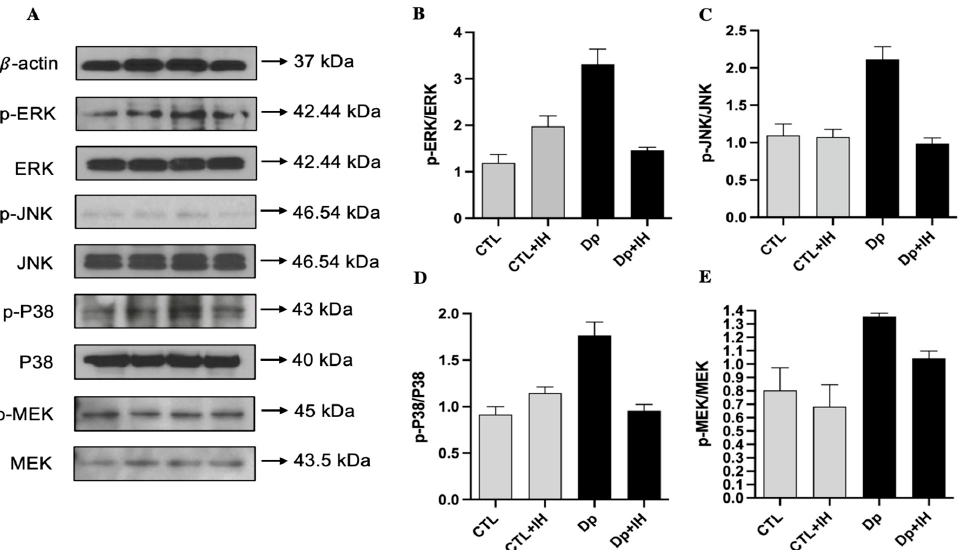
Figure 4. Effects of intermittent hypoxia (IH) exposure to the MAPK pathway on the allergen-induced (Dp) mice model. ( A ) Western blotting for MAPK signaling key factors ERK, JNK, p38, and MEK and their phosphorylated forms before and after 3 days of IH exposure and their molecular weight (kDa). ( B – E ) Relative expression of phosphorylated and total ERK ( B ), JNK ( C ), p38 ( D ), and MEK ( E ). Data in 2 groups: control (CTL) and Dp groups were compared before and after 3 days of IH exposure. Data shown are the mean ± standard deviation ( n = 5).